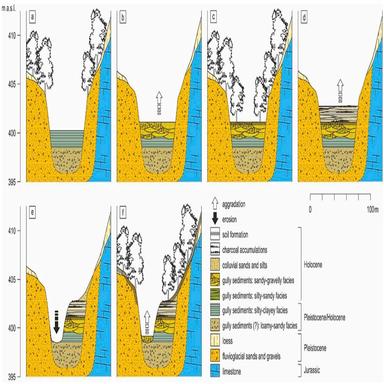
Reconstruction of sedimentary processes in the Załęze ˙ gully: (a) situation before Middle Holocene, the chert deposit did not exist; (b) around 6 ka BP, deposition of the chert-rich sediments (layers 15–11); (c) sedimentological stabilization during Late Holocene, the flint deposit relatively accessible; (d) accumulation of fine sediments during Modern Times (layers 10–1), the deposit not accessible; (e) modern erosion, the deposit accessible again; (f) recent deposition of chert-rich sediment at the gully